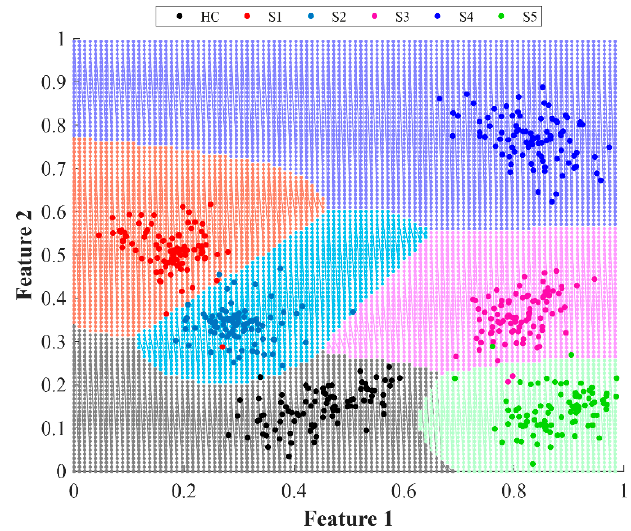
Figure 8. The resulting decision regions achieved during the training of the NN-based classifier for detecting the considered bearing fault severities.